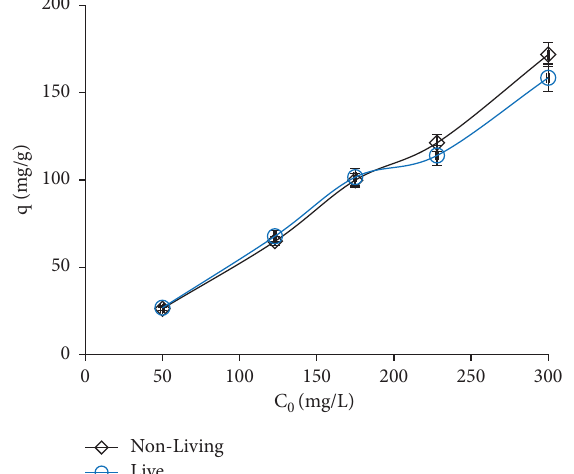
Figure 3: Efect of biomass concentration on the uptake of Pb (II) by Penicillium notatum (pH: 5).